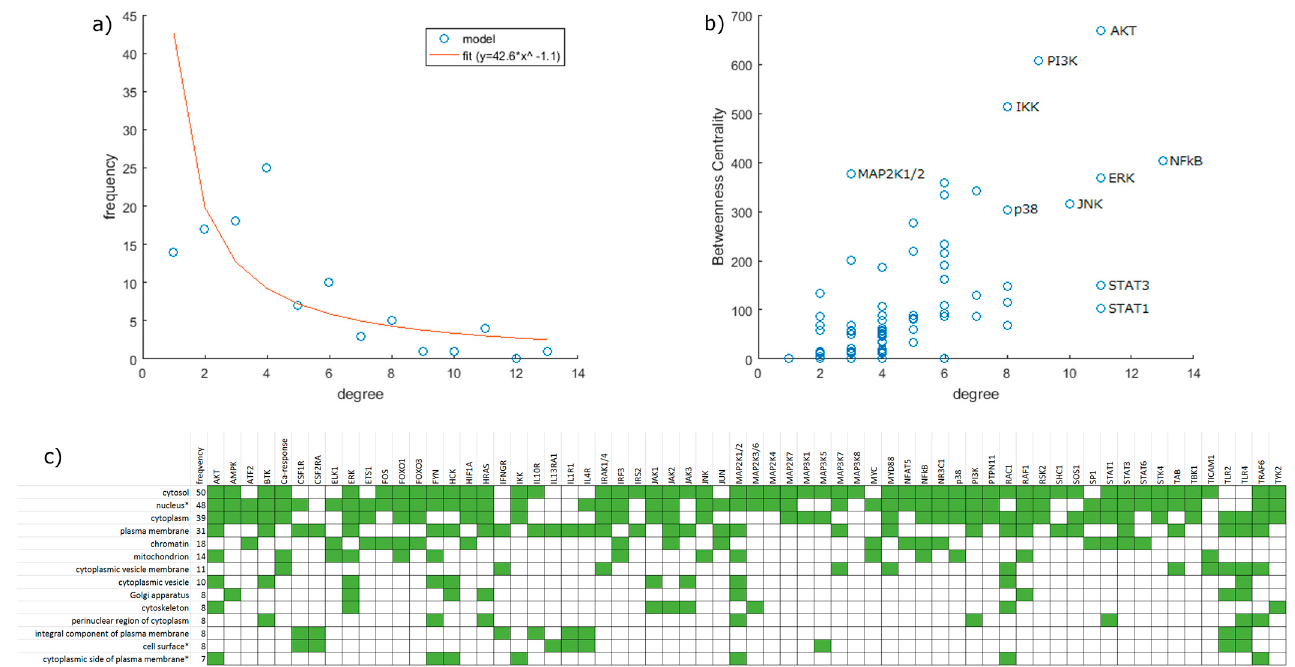
Figure 2. Network statistics. ( a ) Degree distribution of the network. The red line shows a power law curve fitted to the data with degree = 1 and degree = 4 excluded as outliers (R2 = 0.80). ( b ) Betweenness centrality plotted against degree. Some nodes of interest are labeled. ( c ) Cellular localization of proteins represented in the model. Data are based on the Gene Ontology Database. As presented here, terms contain all descendants reachable via “is_a” relations. In specific cases (marked with *), terms with a “part_of” relation were also merged into their ancestors: namely “nucleoplasm” and “nuclear body” were merged into “nucleus”; “external side of plasma membrane” was merged into “cell surface”; and “extrinsic component of cytoplasmic side of plasma membrane” was merged into “cytoplasmic side of plasma membrane”.